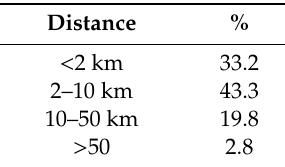
Table 1. Distribution of shift for di ff erent distances, ISFORT 2018